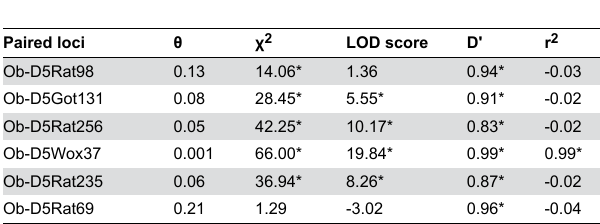
Table 1. Association test scores for obese trait vs markers.